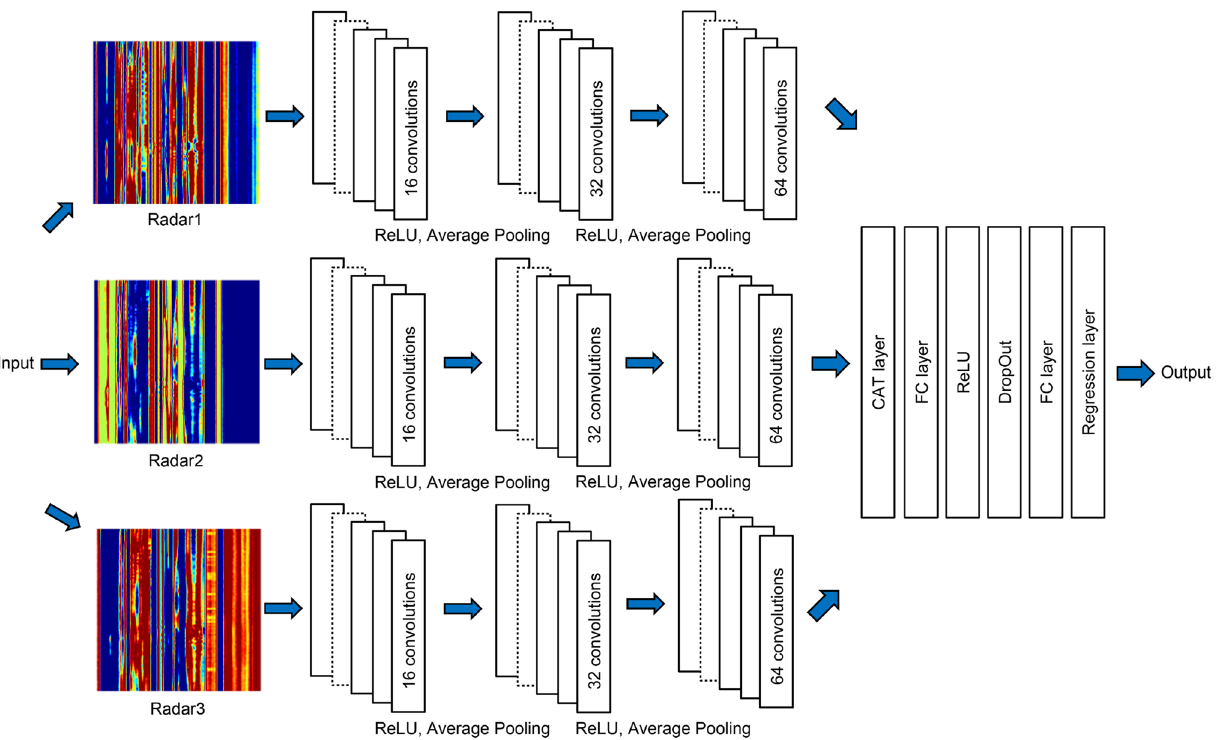
Figure 3. Architecture of the implemented convolutional neural